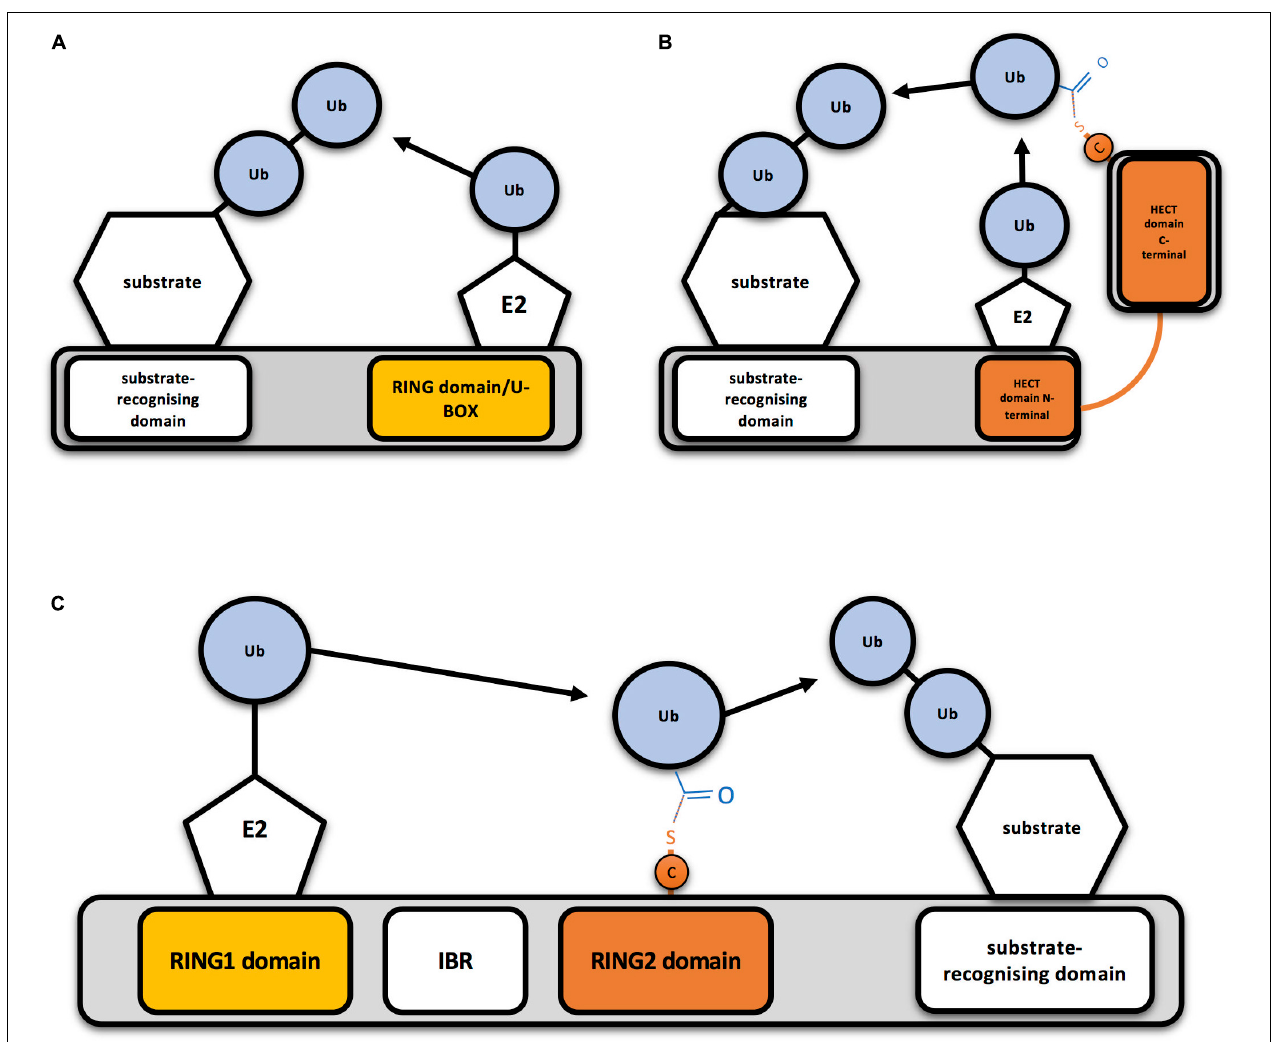
FIGURE 1 | Mechanism of action of RING-, HECT- and RBR-type E3 ubiquitin ligases (A) Schematic representation of a RING-type ubiquitin E3 ligase. RING E3s bind both the E2-ubiquitin and the substrate to be ubiquitinated, so bringing them together allows direct conjugation of ubiquitin (Ub) on the substrate by the E2. A monomeric RING E3 ligase is shown for illustrative purposes. (B) Schematic representation of a HECT-type ubiquitin E3 ligase. Ubiquitin is transferred first to a cysteine (C) of the HECT domain through a thioester bond and then to the substrate. (C) Schematic representation of an RBR-type ubiquitin E3 ligase. Two RING domains are separated by an in-between-RING (IBR) domain. Ubiquitin is first transferred to a cysteine (C) of the second RING domain through a thioester bond and then to the